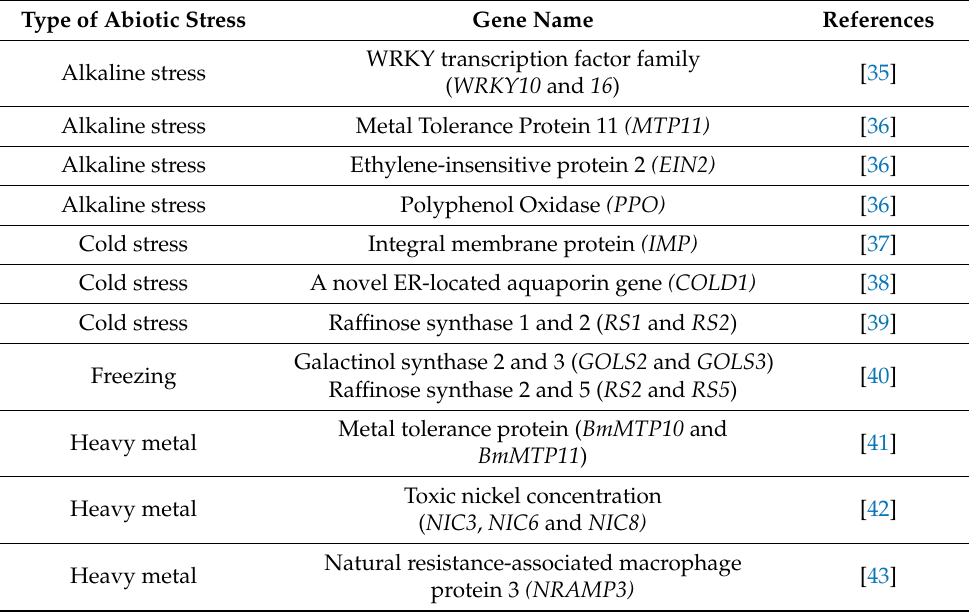
Table 1. Beet genes known to be involved in response to alkaline, cold, and heavy metal stresses. Type of Abiotic